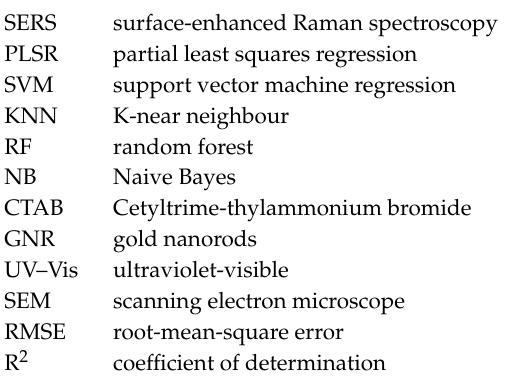
Figure S1: SERS spectra of 5 mg/L fonofo in paddy water using GNRs obtained with addition of 40 (a), 60 (b) and 80 (c) µ L 0.008 M AgNO 3 during the phase of growth. Figure S2: SERS spectra of fonofos (A), phosmet (B) and sulfoxaflor (C) of different concentration in real paddy water. And the reference values were measured using GC-MS. Figure S3: UV–Vis spectrum of GNRs after deposition.Table S1: Pesticide residues in the contaminated paddy water samples. Table S2: Division of calibration set or validation